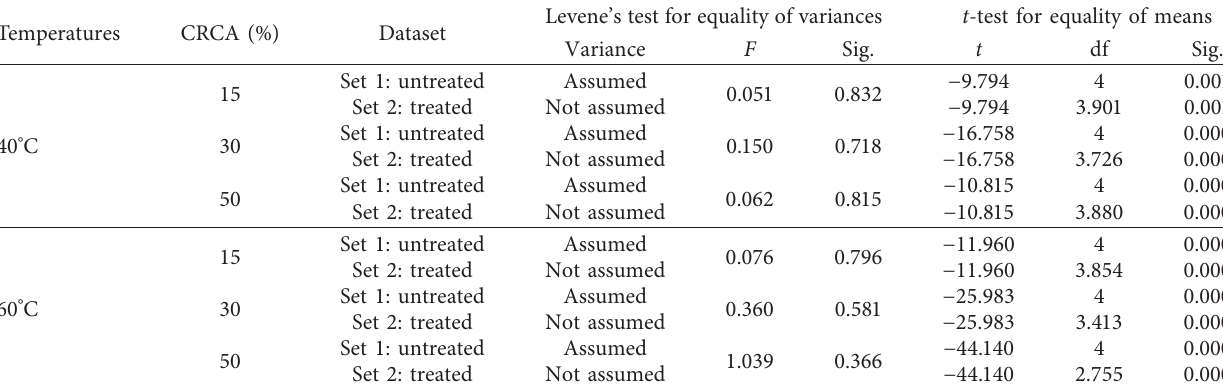
Table 8: Results of t -test to investigate the effect of CRCA percentage on the flow